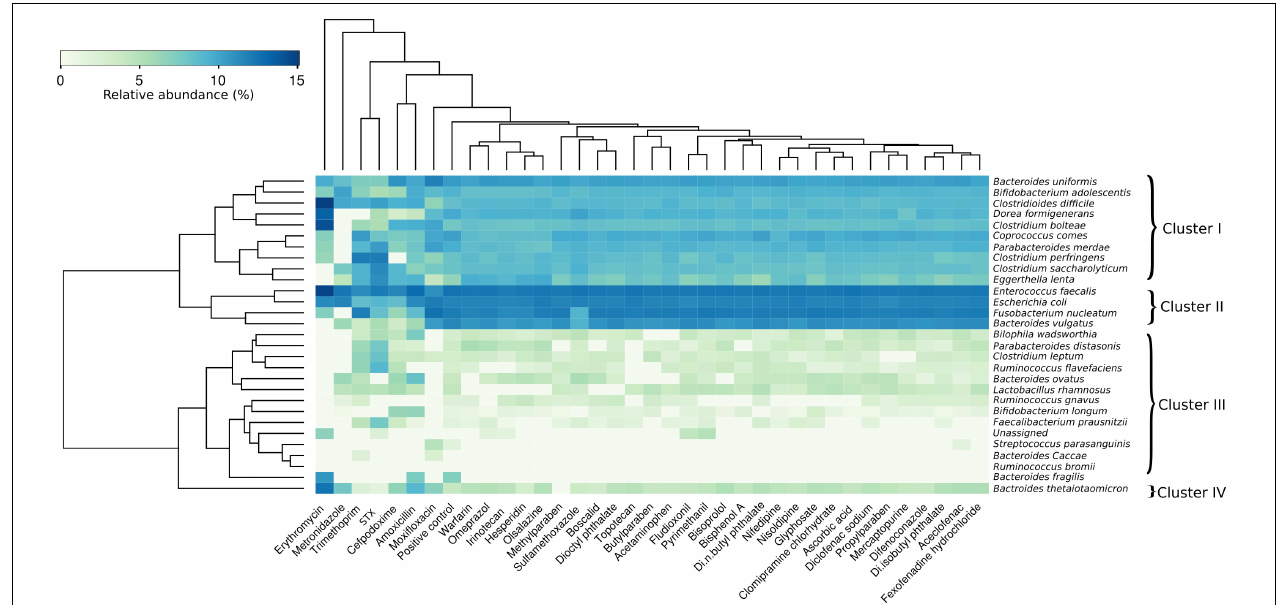
FIGURE 4 | Human gut microbiota model sensitivity at species level to antibiotics, drugs and xenobiotics. Heatmap showing the sensitivity of the bacteria from the consortium model in presence of molecules, following the 48 h incubation compared to the HGMM control cultures without molecule. The color code indicates the relative abundance of the HGMM strains ranging from white (low abundance) to blue (high abundance) in response to the exposure to the different molecules. The clusterization of strains (on the left) was based on their sensitivity to the tested molecules (not on a taxonomic relationship). The clusterization of the molecules (on the top) was based on their effect on the HGMM